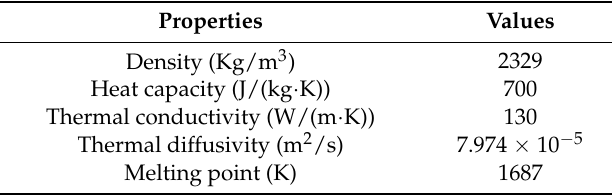
Table 1. Material properties of single crystalline silicon